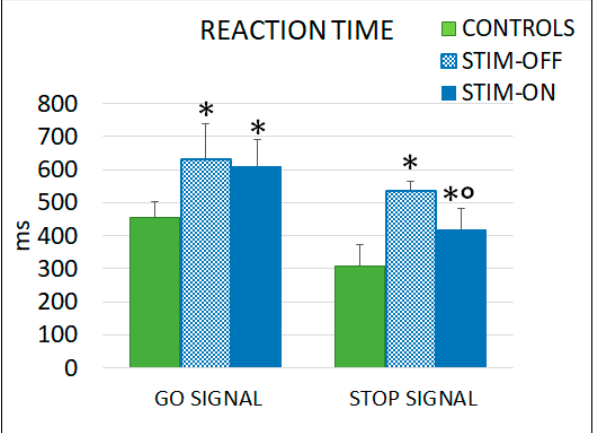
Figure 6. In patients, burst stimulation reduced the duration of the SSRT, while the RT duration was unaffected. Go signal: * p < 0.05 controls vs. OFF and vs. ON; Stop signal: * p < 0.05 controls vs. OFF and vs. ON, ◦ p < 0.05 OFF vs. ON. Statistics were assessed by Mann–Whitney tests.